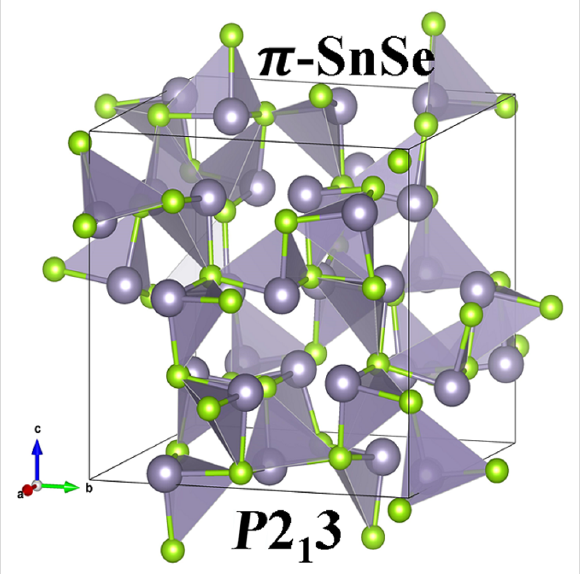
Figure 1: The unit cell of the π -SnSe phase with 64 atoms (Sn = 32, Se = 32) which has a space group P 2 1 3 (no. 198) and a lattice con- stant of 12.20 Å. Grey and green colors represents the Sn and Se atoms, respectively. Each Sn atoms sits on the apex of the trigonal pyramidal surrounded by three Se atoms at the trigonal base with a Sn–Se bond distance of 2.6 Å.